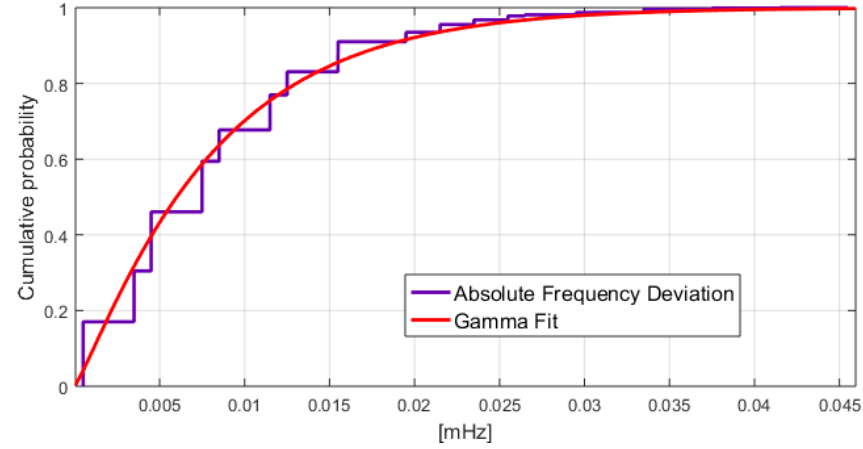
Figure 8. Cumulative probability for Gamma distribution.